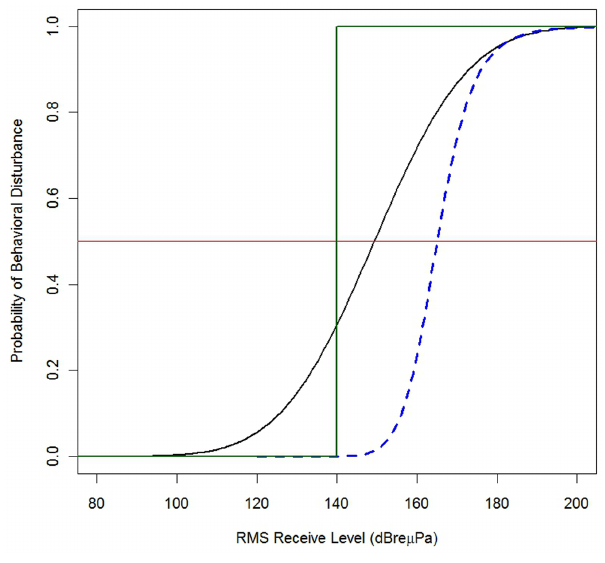
Figure 3. A comparison of risk functions relating the probabil- ity of disturbance to received level for beaked whales exposed to sonar signals. The current step function used by the U.S. Navy is shown by a green line and the historical function by a blue-dashed line. The empirical function developed in this paper is shown by a solid black line. A solid red line marks the.5 probability of disturbance.